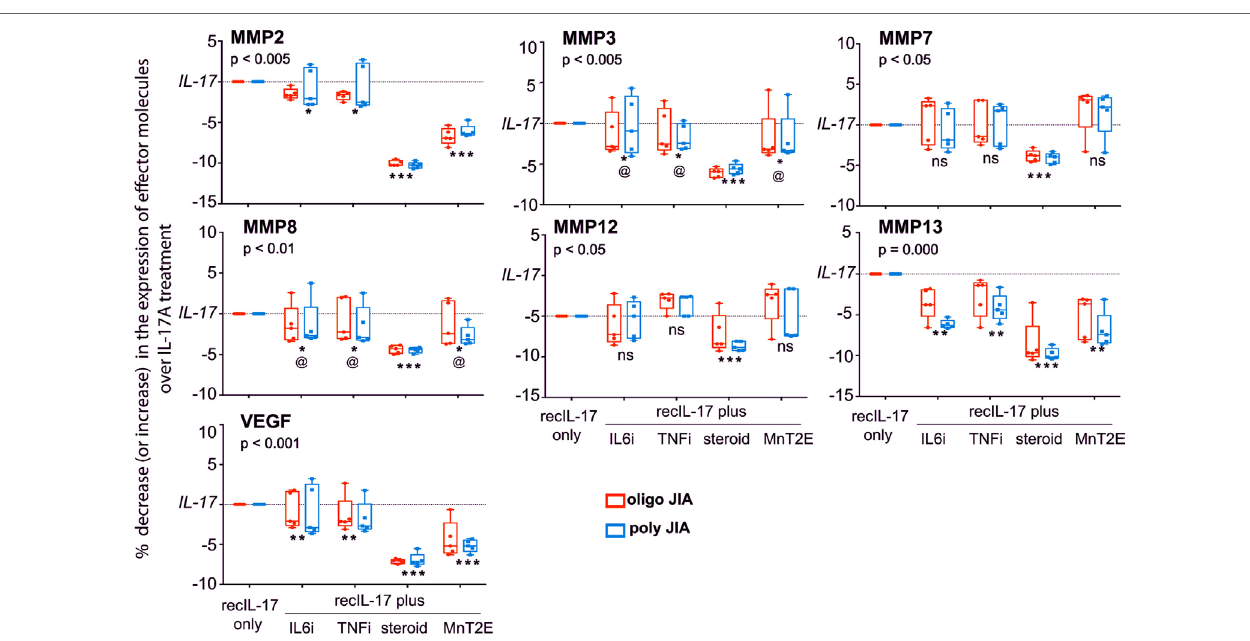
FigUre 9 | Sensitivity of IL-17A-mediated production of tissue-destructive proteins by FLC to down modulation by MnT2E. Culture supernatants from the same FLC bioassays in Figure 8 were also examined for MMPs and vascular endothelial growth factor (VEGF). Sample sizes, box-median-whisker plots, and statistical analyses were identical to that of Figure 8 .